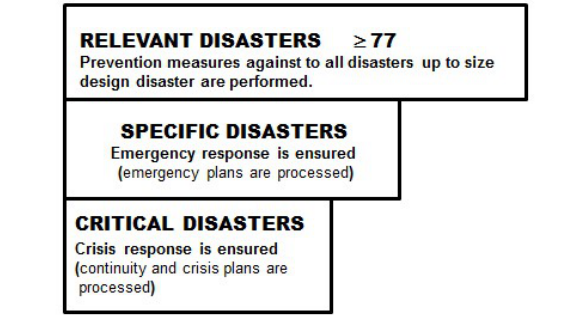
Figure 4. Measures used for get over risks connected with disasters [3] [4]